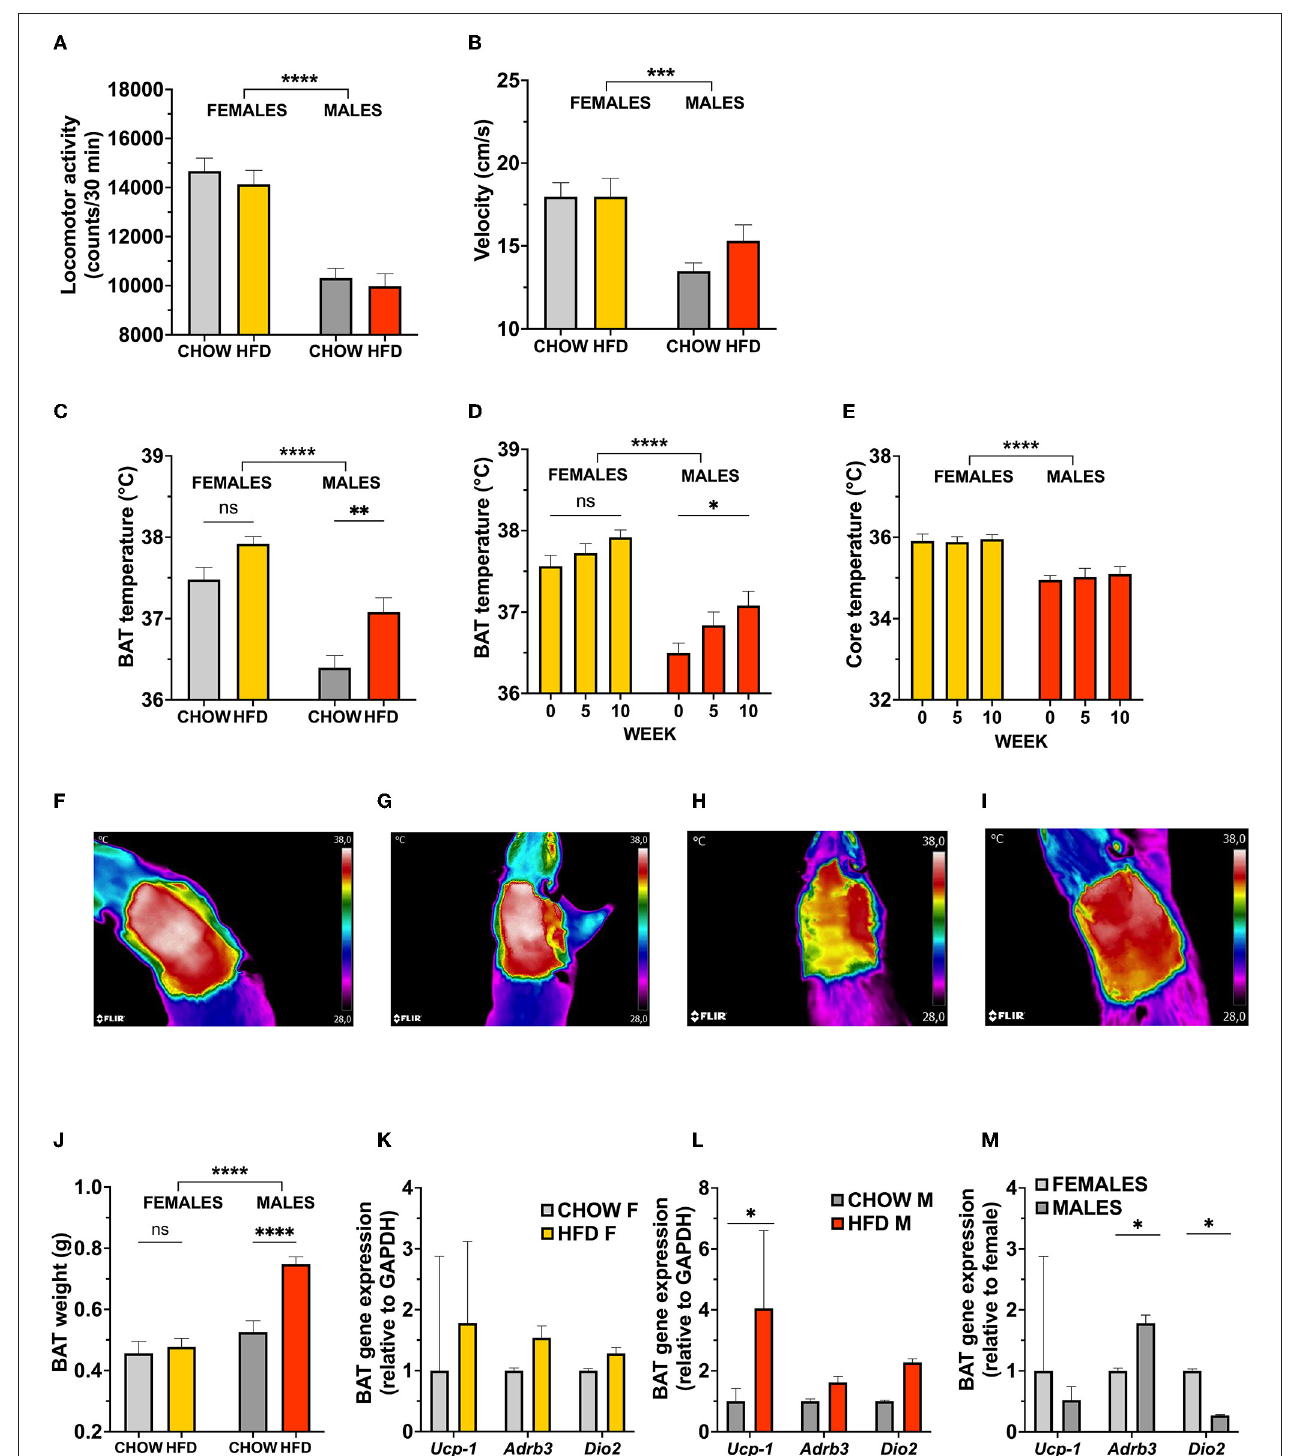
FIGURE 2 | Activation of brown adipose tissue thermogenesis in response to a high-fat choice diet challenge is dictated by sex in rats. Male locomotor activity (A) , and velocity (B) was significantly higher in female rats, but remained unaffected by diet in either sex when measured during a 30-min test. Furthermore, infrared images reveal a higher basal core temperature and thermogenic activity of BAT in females, which remains statistically unaltered with HFD (C) . In contrast, high-fat fed male rats showed a potent increase in BAT temperature (D) , and BAT weight (J) , with no subsequent changes in core temperature (E) . Representative infrared images of BATregioninfemale( F,G ;chowandHFD,respectively)andmale( H,I ;chowandHFD,respectively)rats.IncreasedBATtemperatureactivityinmales( n = 8perdietgroup)